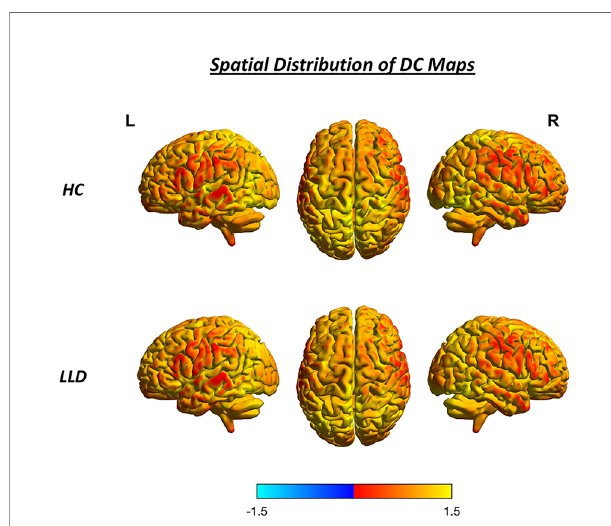
FIGURE 1 | Spatial distribution of DC maps in the HC group and the LLD patient group. Color bars indicate DC values; brighter color indicates DC values higher than the whole-brain average. HC, healthy control; L, left; LLD, late-life depression; R, right.